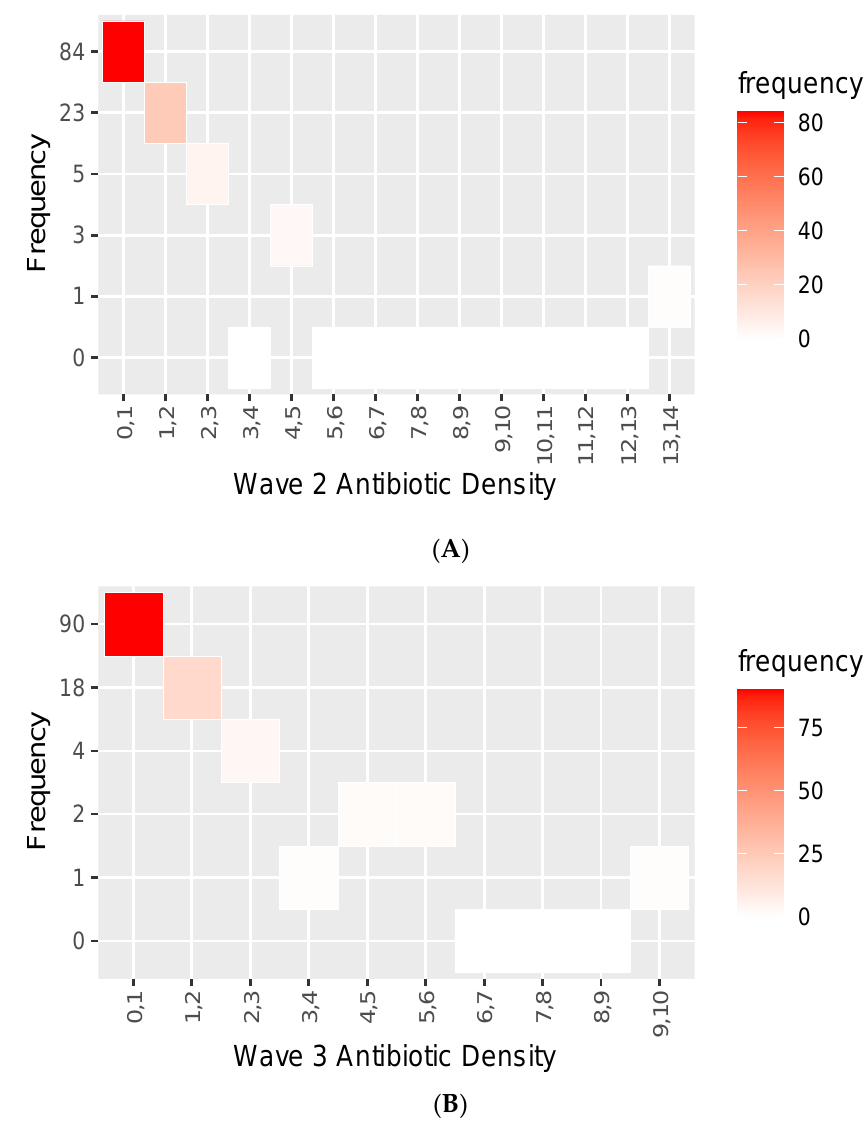
Figure 6. Histogram showing antibiotic / antimicrobial density during ( A ) Wave 2 and ( B ) Wave 3.